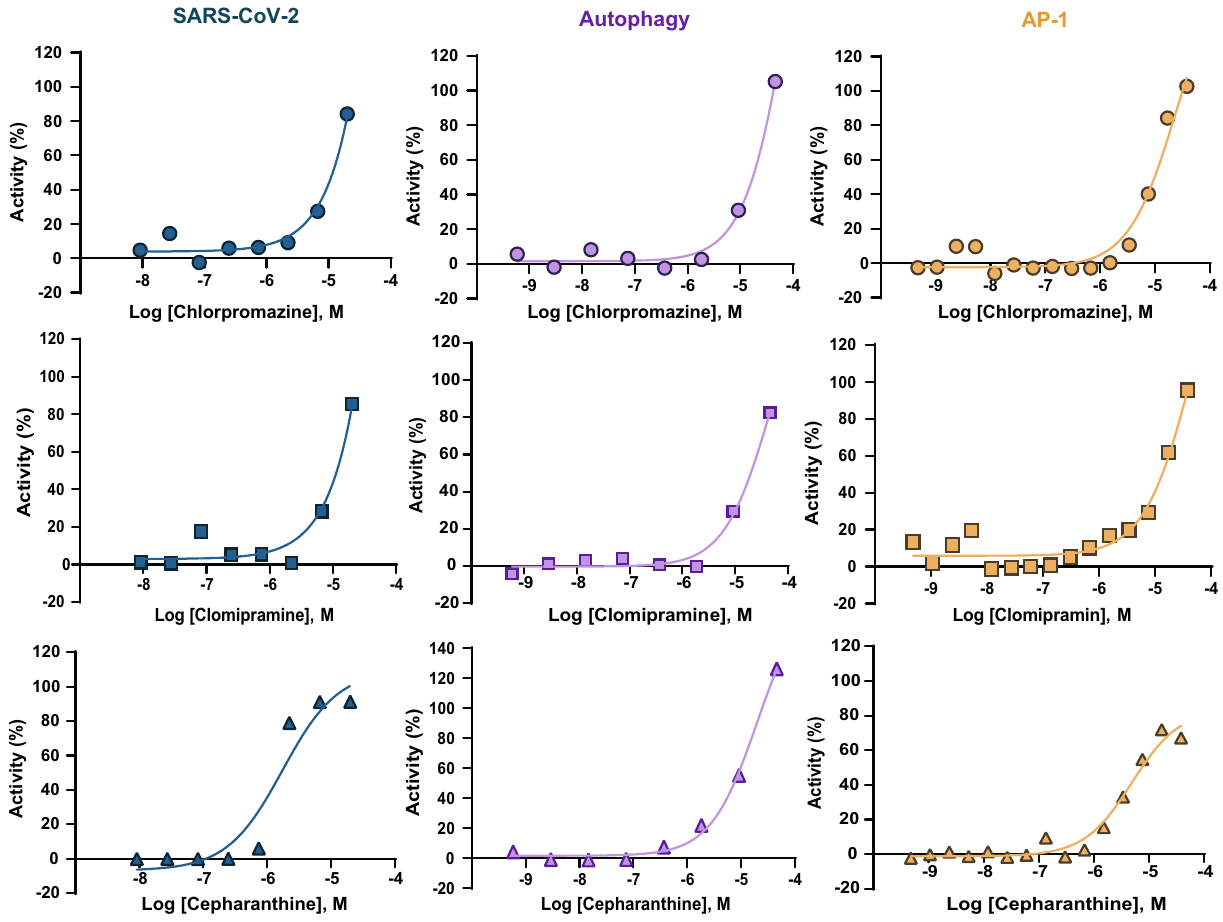
Figure 3. Example concentration–response curves of compounds active in the SARS-CoV-2, autophagy, and AP-1 assays. Chlorpromazine is a tricyclic antipsychotic, clomipramine is a tricyclic antidepressant, and cepharanthine is a natural product anti-inflammatory that is approved in Japan 66